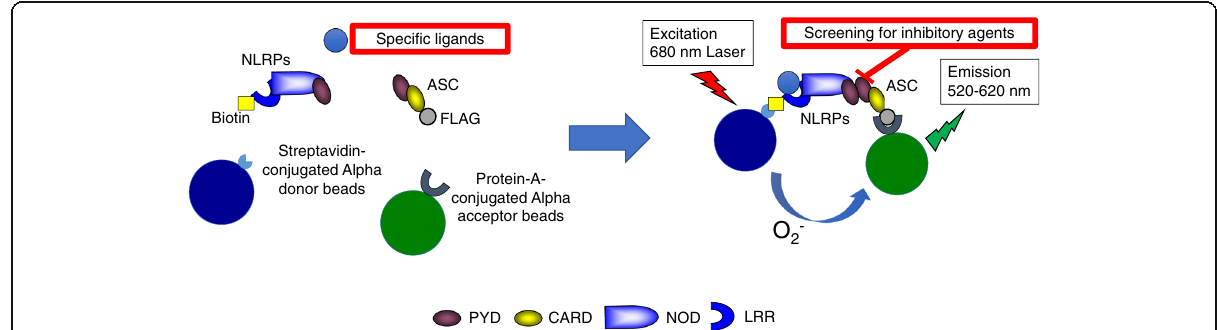
Fig. 1 Schematic representation of reconstituted inflammasomes. Once specific ligands are recognized by NLRPs, inflammasomes are constituted. Then, chemical energy of reactive oxygen from donor beads is transferred to acceptor beads and a signal is